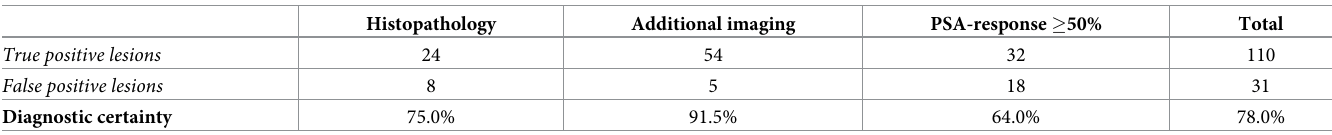
Table 2. Diagnostic certainty of 18 F-DCFPyL PET-detected